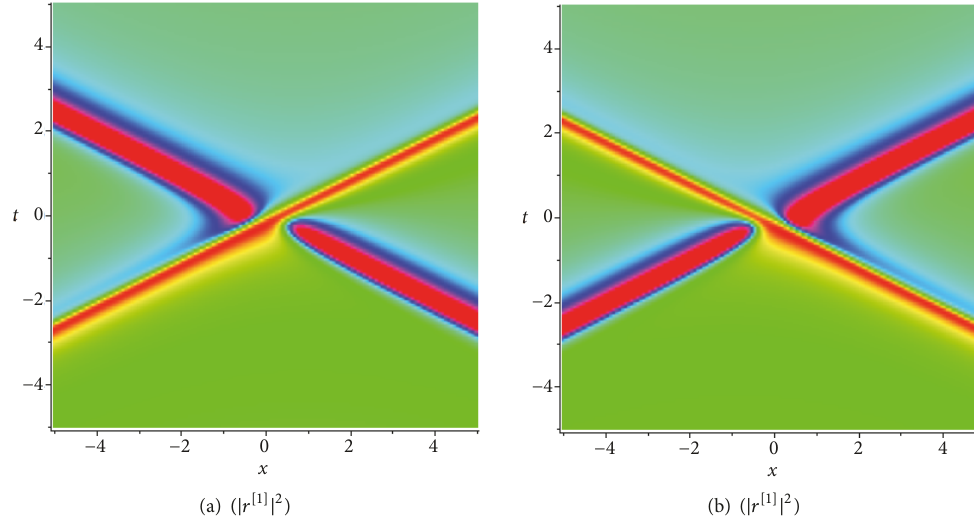
Figure 4: Density plots of |𝑟 [1] | 2 on (𝑥,𝑡) -plane associated with Figure 1. (a) The bright-bright 1 structure: (𝐽 1 , 𝐽 2 ) = (0.2,−0.1) . (b) The bright-bright 2 structure: (𝐽 1 ,𝐽 2 ) = (3,−1) .